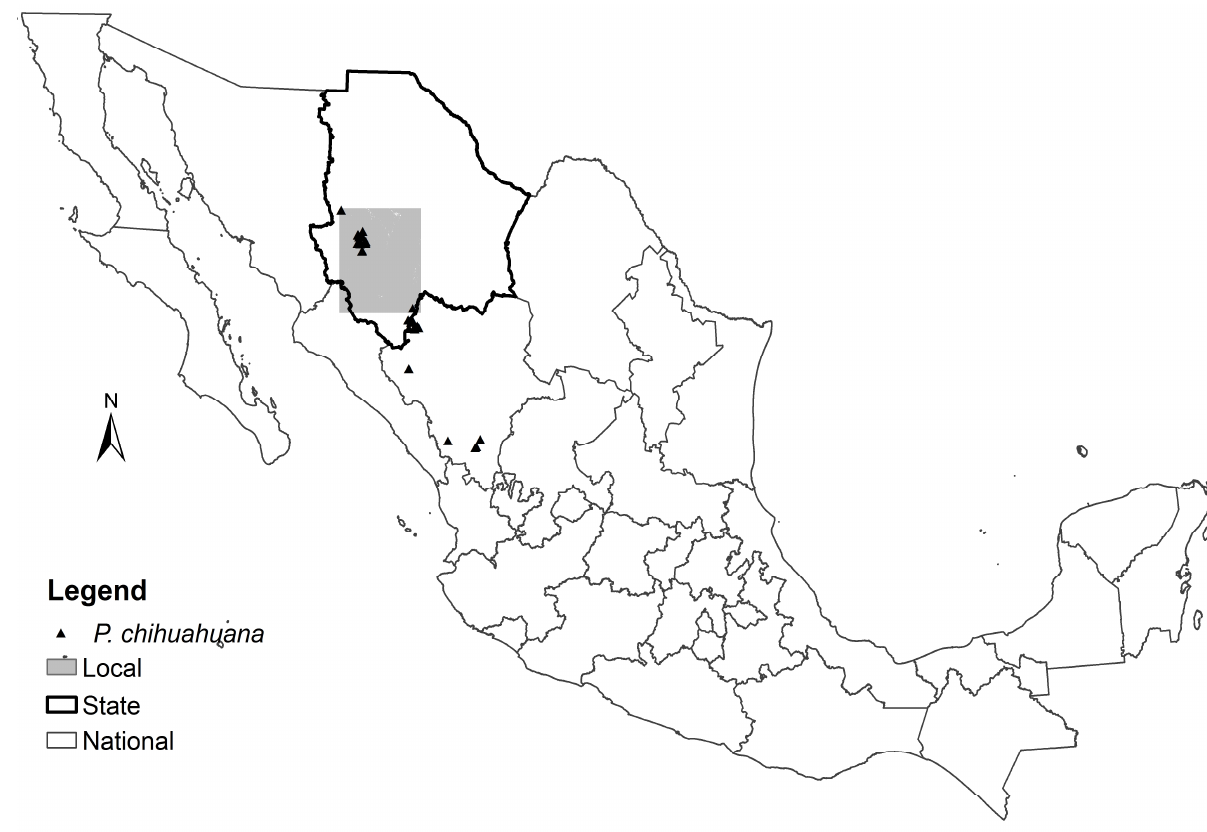
Figure 1. Study area for Picea chihuahuana Martínez in